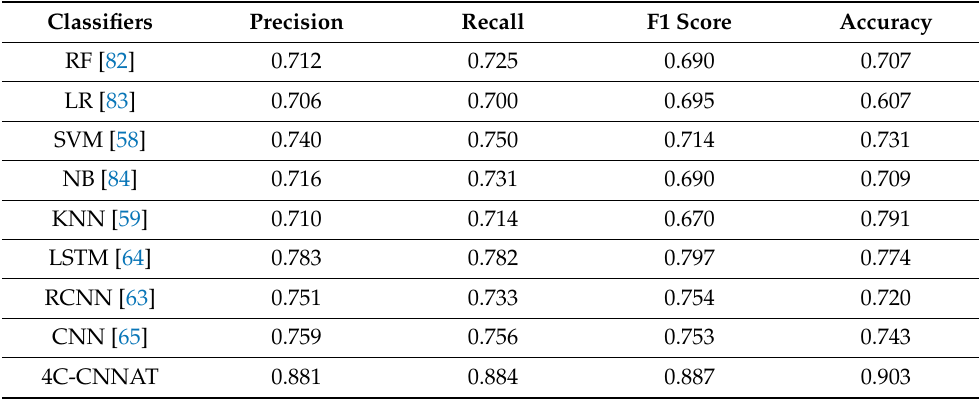
Figure 5. ( a ) classification accuracy on source datasets with different activation functions; ( b ) classification accuracy on source datasets with different Dropout values. Table 5. 4C-CNNAT performance comparison with various ML/DL classifiers using RUDS corpus.